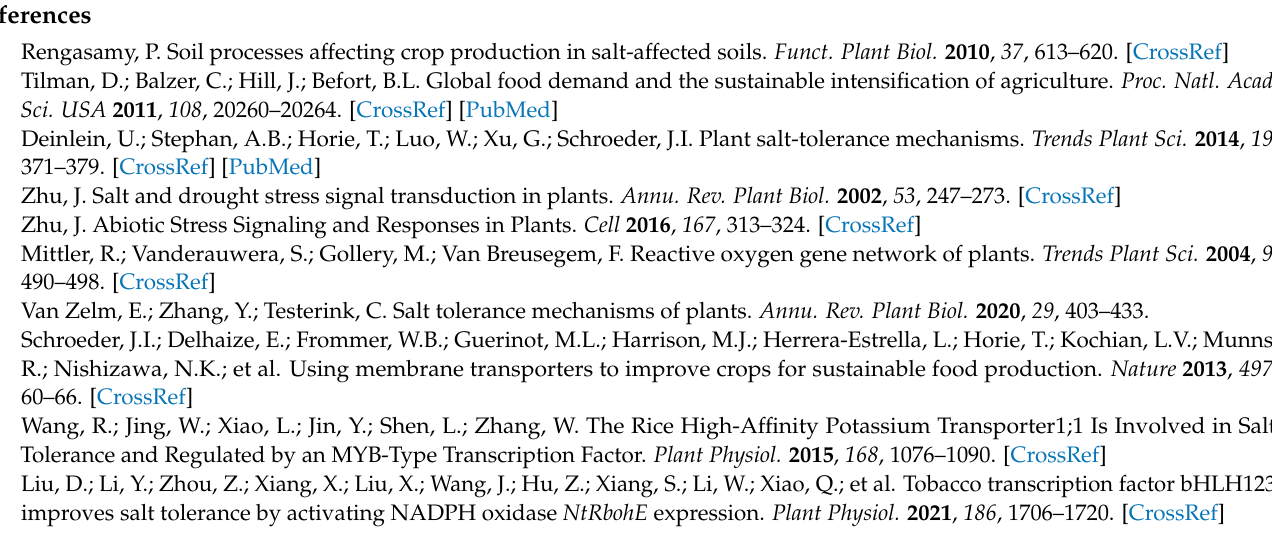
classification of all the DEGs. Table S4. Salt-tolerance genes identified in FL478 relative to 93-11. Table S5. GO enrichment of salt-tolerance genes identified at 6 h, 24 h, and 72 h upon salt stress, respectively. Table S6. The list of salt-tolerance genes related to transporters. Table S7. The list of salt tolerance genes related to transcriptional factors. Table S8. The list of salt-tolerance genes related to ROS. Table S9. The list of co-expression genes presented in Figure